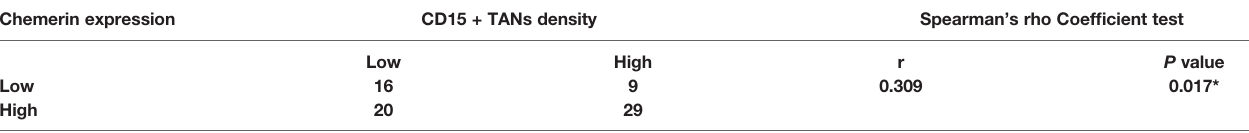
TABLE 2 | The relationship between Chemerin expression and TANs density in OSCC tissues. Chemerin expression